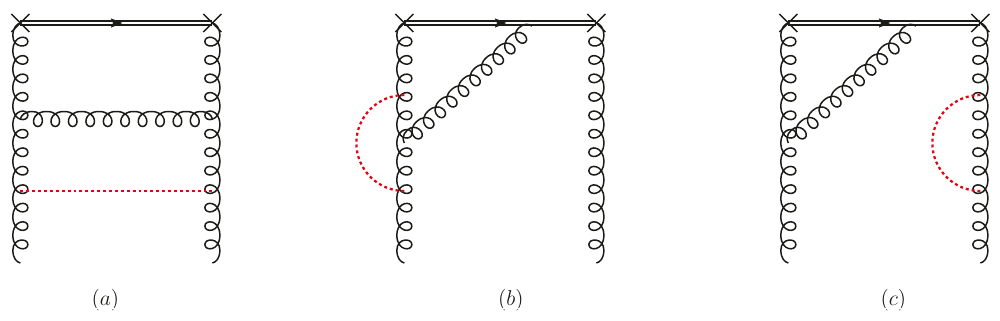
Figure 8 . Typical two-loops corrections to quasi gluon distribution, in which the added internal line (denoted by dotted line) is not connected to the Wilson